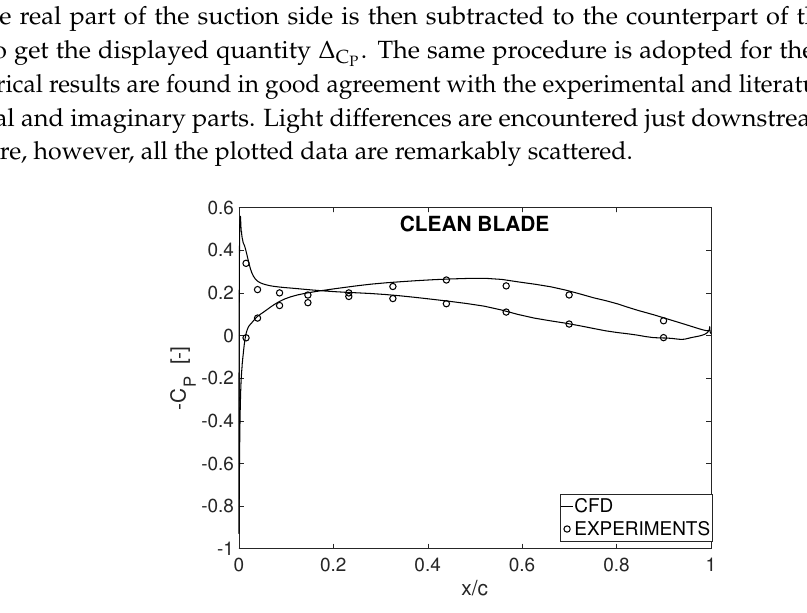
Figure 5. Distribution of pressure coefficient C P . Experiments and CFD on the clean configuration; Re ∼ 350,000, α = 2 degrees.